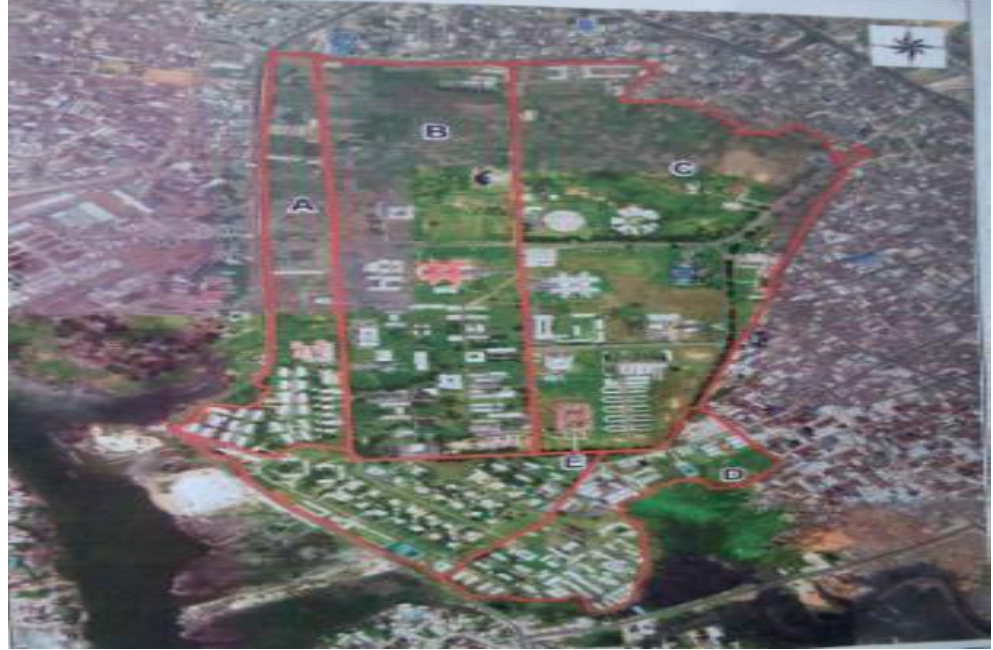
Figure 1: Ortho-Photo Base Map of Rivers state University Portharcourt